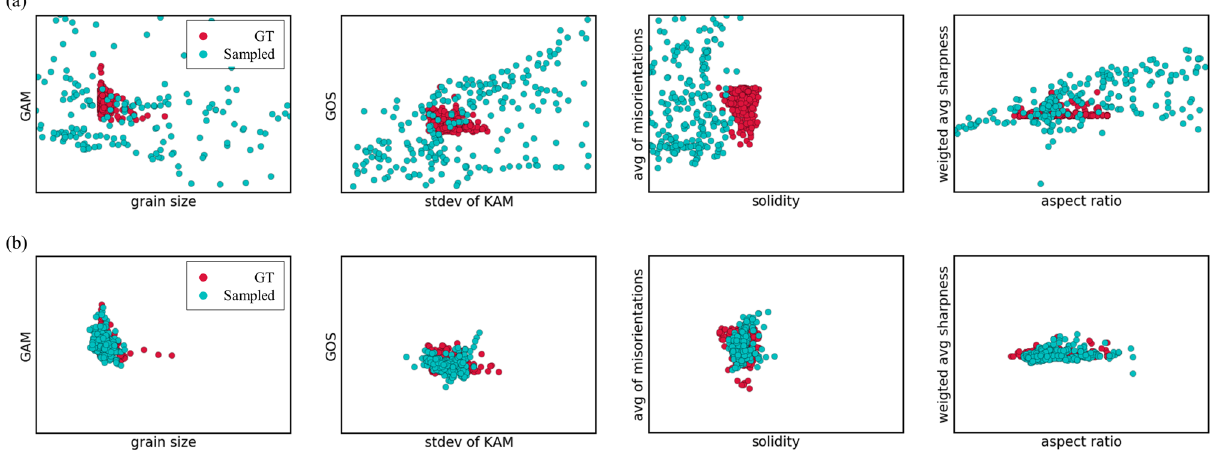
Figure 6. ( a ) Sampled points at epoch 100 for Steel E. ( b ) Sampled points at epoch 11,000 for the same steel. The ground truth is shown in red dots while the sampled points are in green